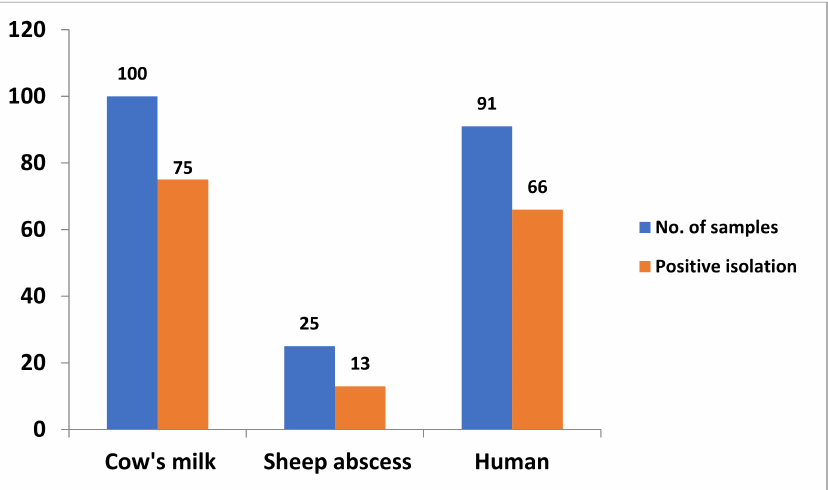
Figure 1. Staphylococci prevalence in the collected